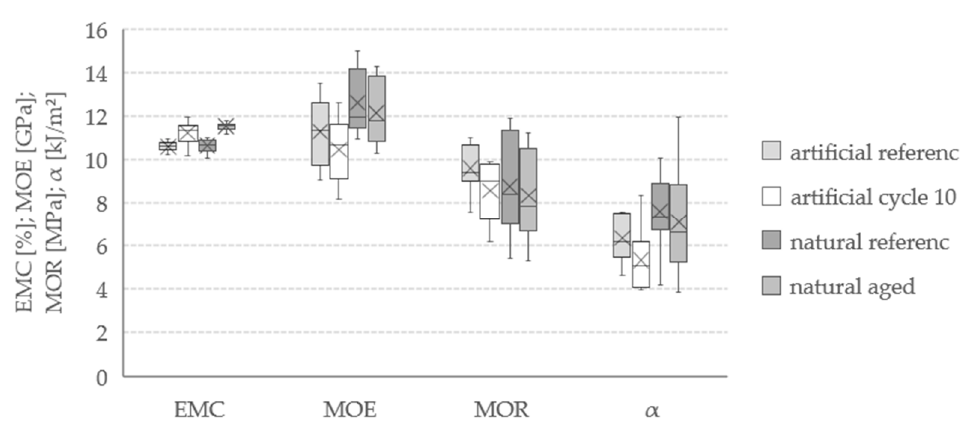
Figure 3. EMC, modulus of elasticity (MOE), bending strength (MOR) and impact bending strength ( α ) of artificially and naturally weathered oak solid wood ( n = 11 samples). The whiskers present minimum and maximum values, x is the mean value and–is the median.